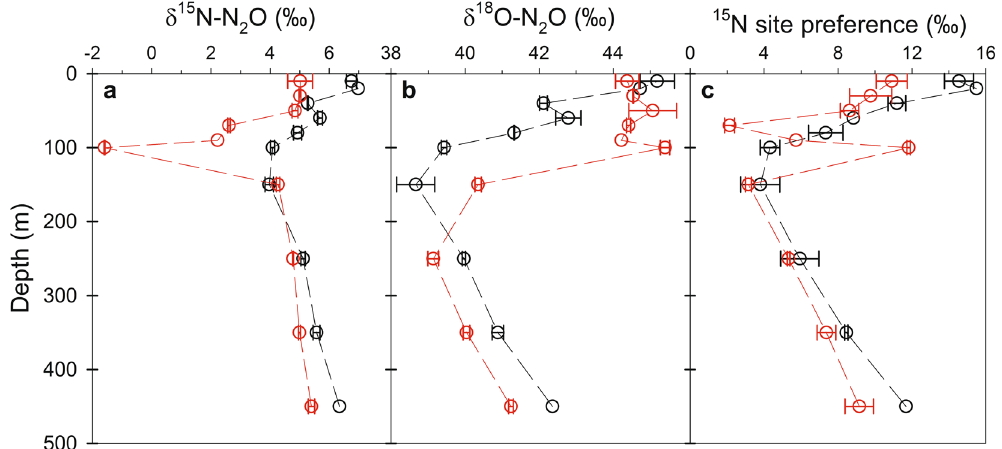
Figure 5. Vertical distributions of ( a ) δ 15 N-N 2 O, ( b ) δ 18 O-N 2 O and ( c ) 15 N site preference signatures at ES1 (red circles) and OES (black circles). Error bars represent the standard deviation of duplicate N 2 O isotope measurements. Due to the loss of duplicated samples, standard deviations are not reported for 20 and 450 m depth at OES, and 90 m depth at